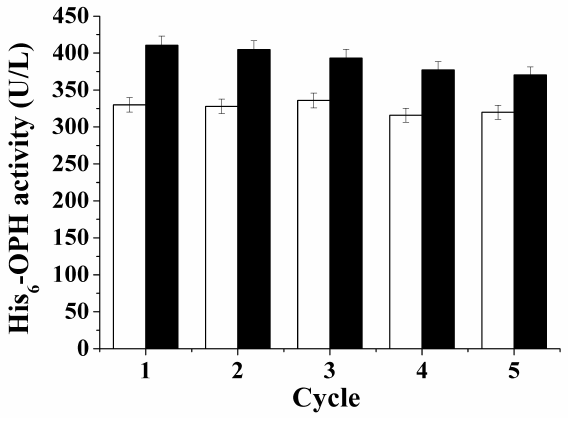
Figure 3. Accumulation of the total His 6 -OPH activity in the course of multiple batch re-use of PFH (white bars–control, black bars—cells cultivated in the medium containing 0.5% ( v / v ) of PFH).